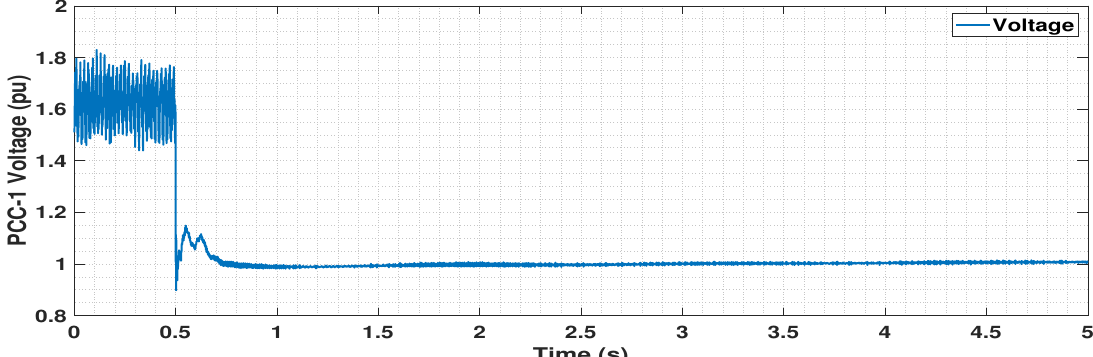
Figure 20. Voltage in p.u. at PCC-1 upon connecting OWF-1 with 50 MW generation to the network.